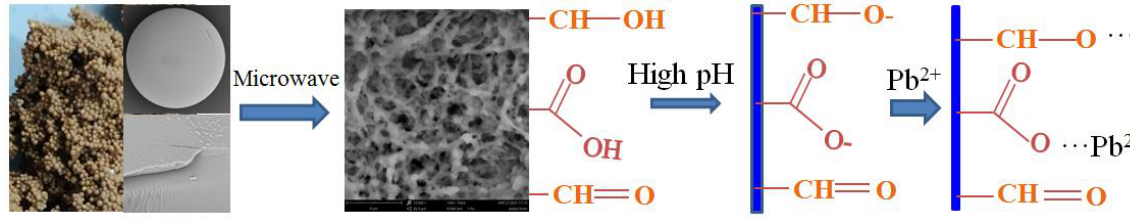
Figure 11. The schematic diagram of the possible adsorption mechanism of the MT-WAO.